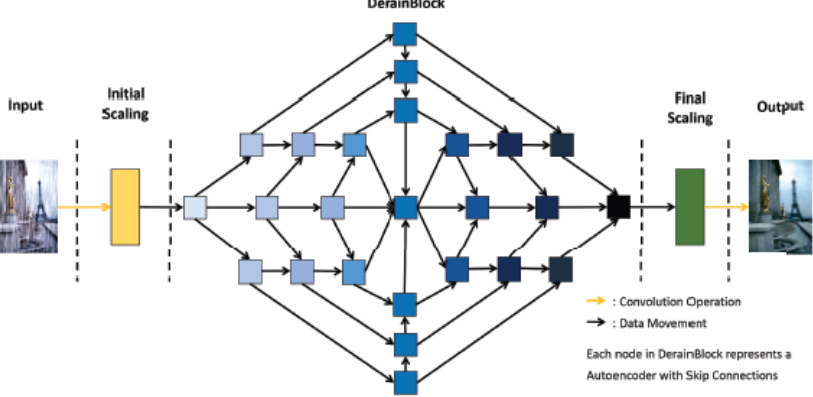
Figure 3. Schematic of the SphinxNet method by Jasuja et al. [84]. Encoder and decoder modules are arranged hierarchically to allow for multi-scale feature encoding and